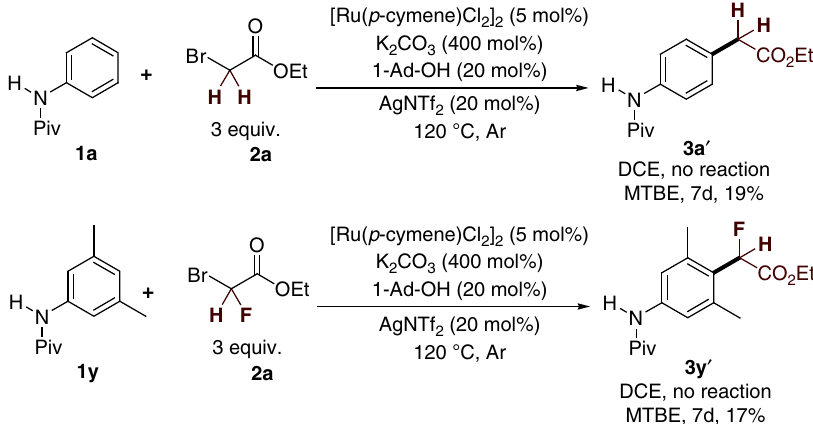
Fig. 2 Mono fl uoromethylation and non- fl uoromethylation. a Ruthenium(II)-enabled para -selective non- fl uoromethylation. b Ruthenium(II)-enabled para -